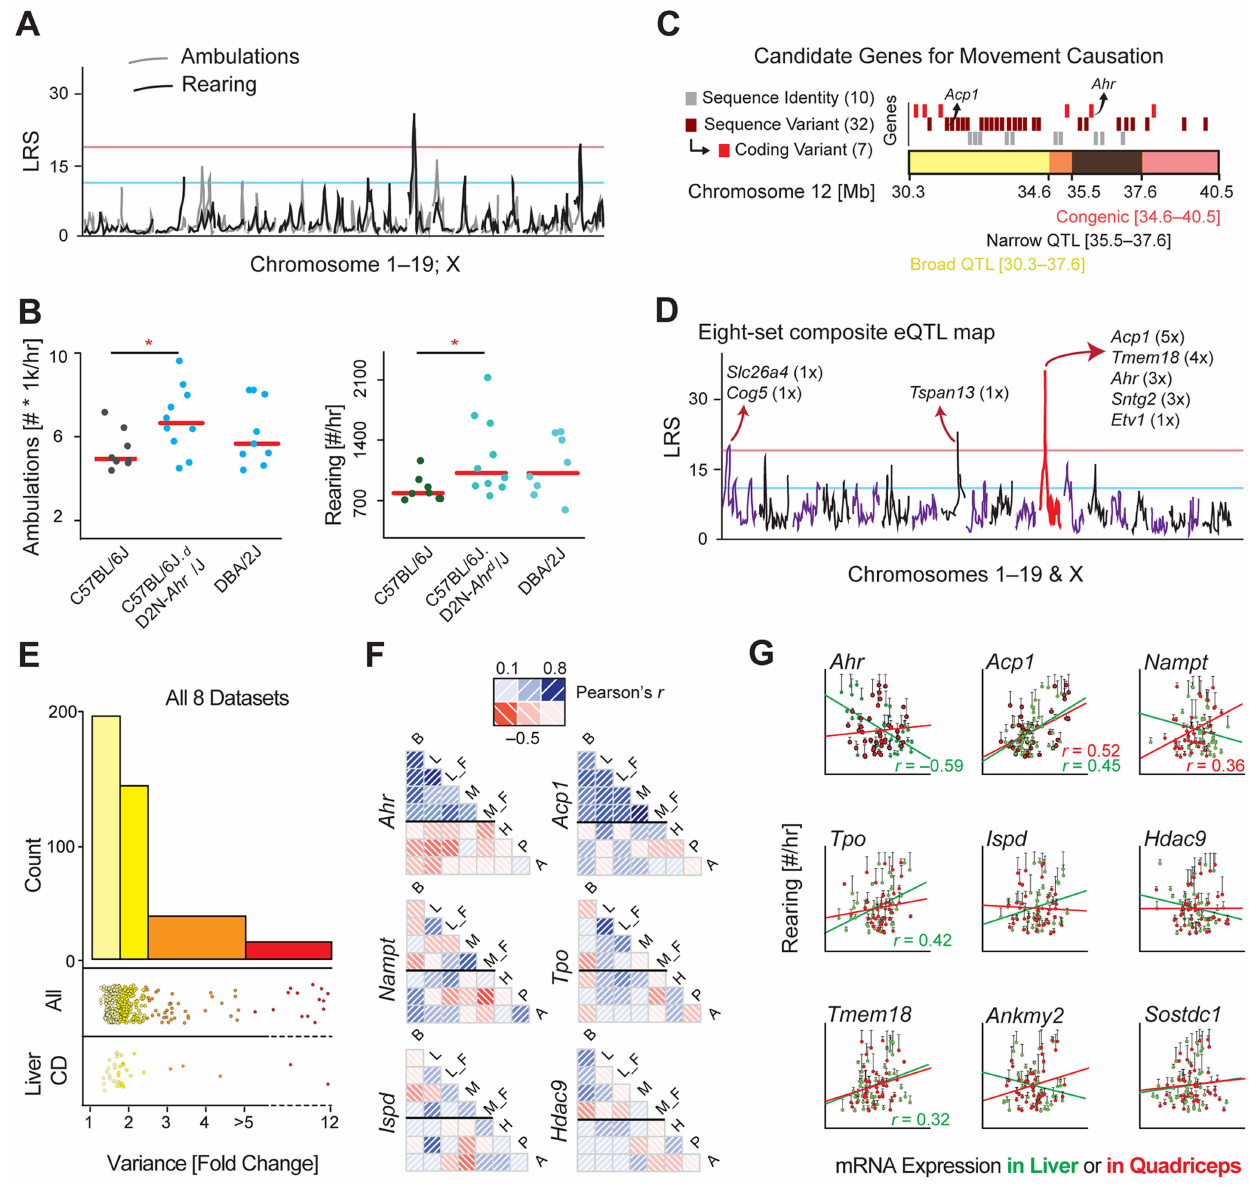
Figure 2. Identification of the movement QTG: Ahr . ( A ) The movement QTLs across all chromosomes indicates one consistently significant locus on chromosome 12, and one significant locus on chromosome 19 only for rearing activity. ( B ) A congenic strain on a B6 background with a D2 congenic interval at the region of the chromosome 12 QTL has significantly more spontaneous movement, validating that this locus impacts movement. One-way ANOVA is suggestive ( p =0.09), while the t -test between only the congenic and control groups is significant ( p =0.01). ( C ) Close- up of the congenic (red) and overlapping significant QTL (black) and suggestive (yellow) regions on chromosome 12. All genes are represented by rectangles at their approximate chromosomal positions. Genes that are sequence identical across the BXDs are marked in grey and were discounted. Genes with sequence variants of unknown effect (maroon) and genes with sequence variants with clear effects (e.g. coding differences, red) were considered more likely candidate QTGs. ( D ) eQTLs were plotted for all positional candidates in all eight datasets tissues. Five genes map to chromosome 12 ( , 25–45 Mb) as cis -eQTLs. As the movement QTL also maps to this locus, trans -eQTLs are of less interest. ( E ) Transcript variance was checked across all 9 datasets. Half of the transcripts are at least moderately variable (range . 1.75 fold) across the cohorts, while 9% of transcripts are highly variable ( . 3.0 fold). Upper stripchart: Variance of all 42 candidate genes in all 8 tissues (i.e. each gene is represented , 8 times). Lower stripchart: Variance of all 42 candidate genes in CD liver. ( F ) Few transcripts are consistently expressed across strains in different tissues (Brown Adipose: B; Liver: L; Muscle: M; Hypothalamus: H, Pituitary: P, Adrenal: A; F: High fat fed cohorts; all others are chow fed). Ahr covaries well for all five datasets taken from this study, but negatively with the three publicly available BXD datasets; Acp1 covaries positively in all datasets, although much stronger in the five paired sets. Most other genes (e.g. the four shown) have little consistency. ( G ) Gene expression correlates with movement inconsistently by tissue, with only a handful of genes yielding consistent ( Acp1, Tpo, Tmem18 ) or significant ( Ahr, Acp1 ) correlations. Nominally significant correlations ( p , 0.05) are displayed on the chart. For brown adipose tissue, no genes correlate highly significantly ( p , 0.01) with activity.